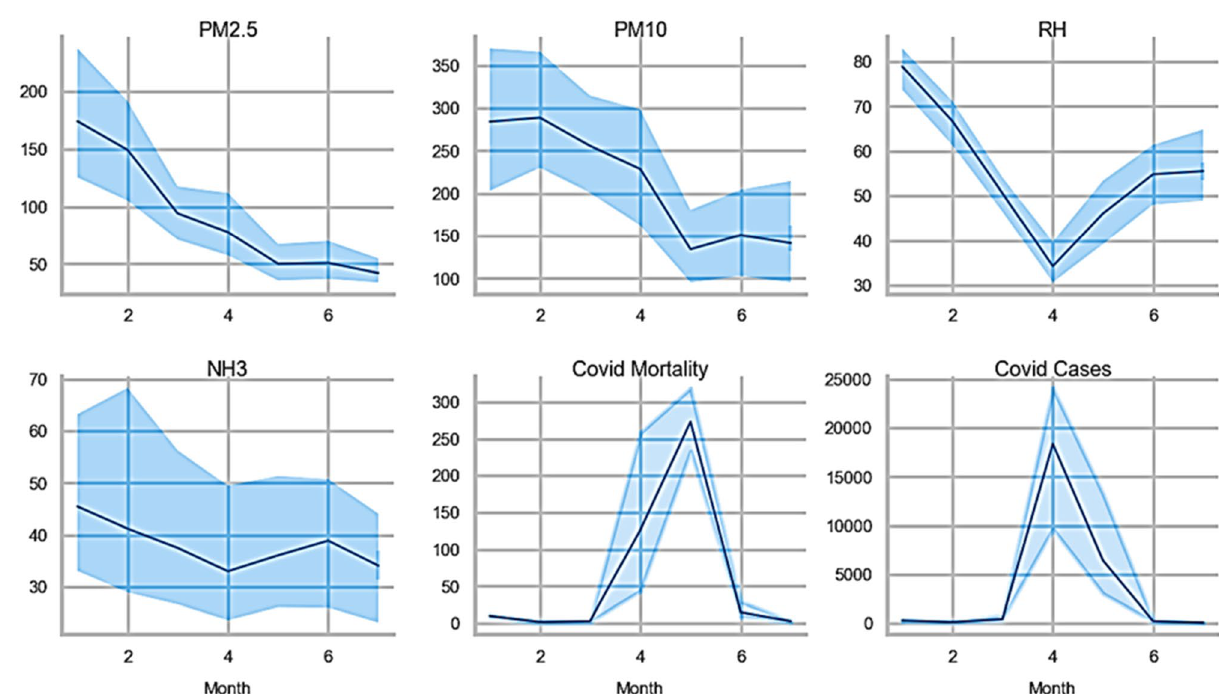
Figure 3. Month-wise distribution of variables including environmental risk factors and COVID-19 severity through-line